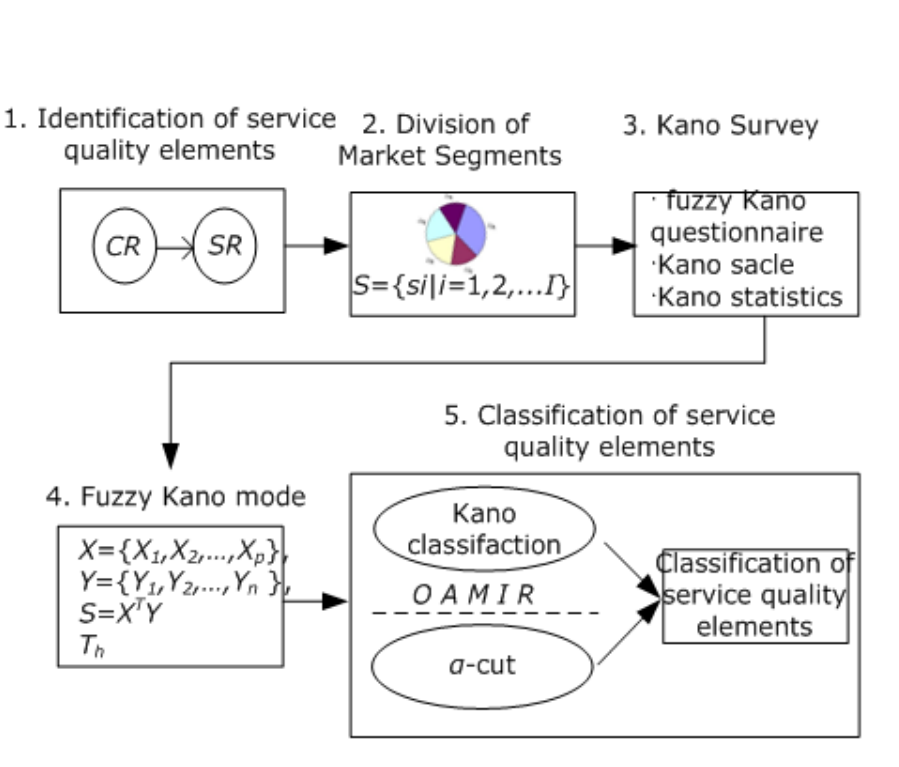
Figure 1. The classification process of service quality elements based on fuzzy Kano